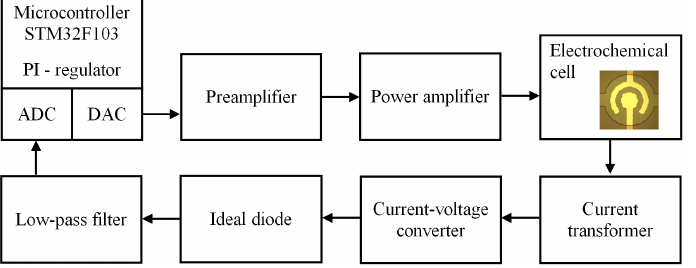
Figure 2. Operation scheme of the generator with a built-in current stabilization system. The membrane deflection is registered by a Michelson interferometer with orthogonal signals [39]. In order to increase the reflectivity, a 20 nm thick Al layer is deposited on the membrane. The voltage and current flowing through the electrodes are recorded by an oscilloscope, the PicoScope 5444D. The average current I a during the AP series and the power P consumed by the actuator per cycle are calculated from the waveforms of voltage U ( t ) and current I ( t ) as